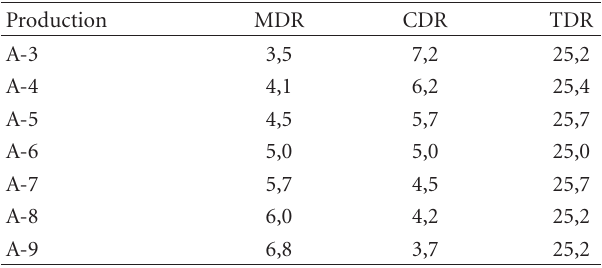
Table 1: The melt draw ratio (MDR) and cold-draw ratio (CDR) of the obtained monofilaments. The total draw ratio (TDR) is calculated by multiplying MDR with CDR.